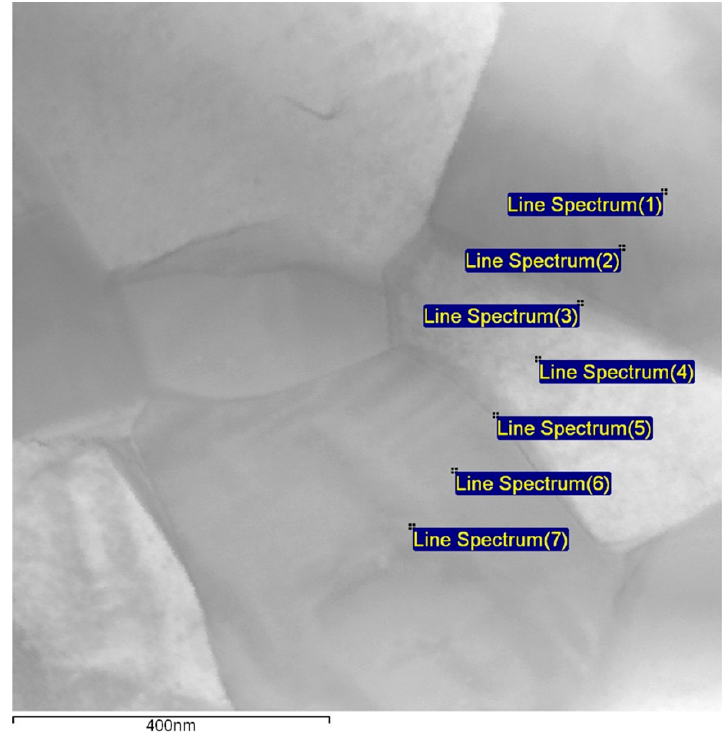
Figure 6. STEM BT02-MOD-Y with marked points for EDX. Table 1. EDX analysis of di ff erent points in KZM100-MOD-Y. Spectrum